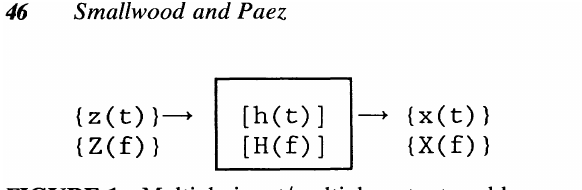
FIGURE 1 Multiple input/multiple output